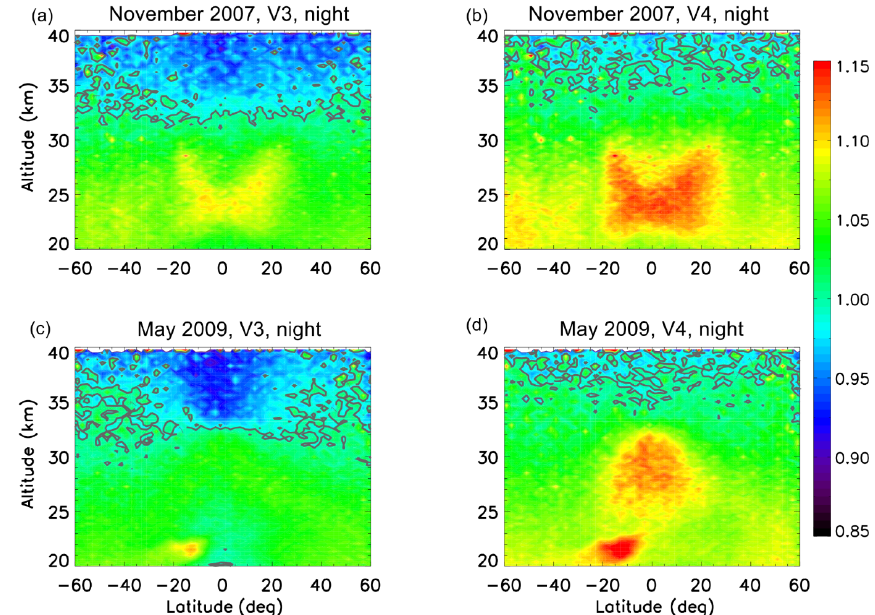
Figure 16. Zonally averaged height–latitude cross sections of R (cid:48) calculated using V3 and V4 Level 1 data for November 2007 (a, b) and for May 2009 (c, d) . The contour lines shown are for R (cid:48) =